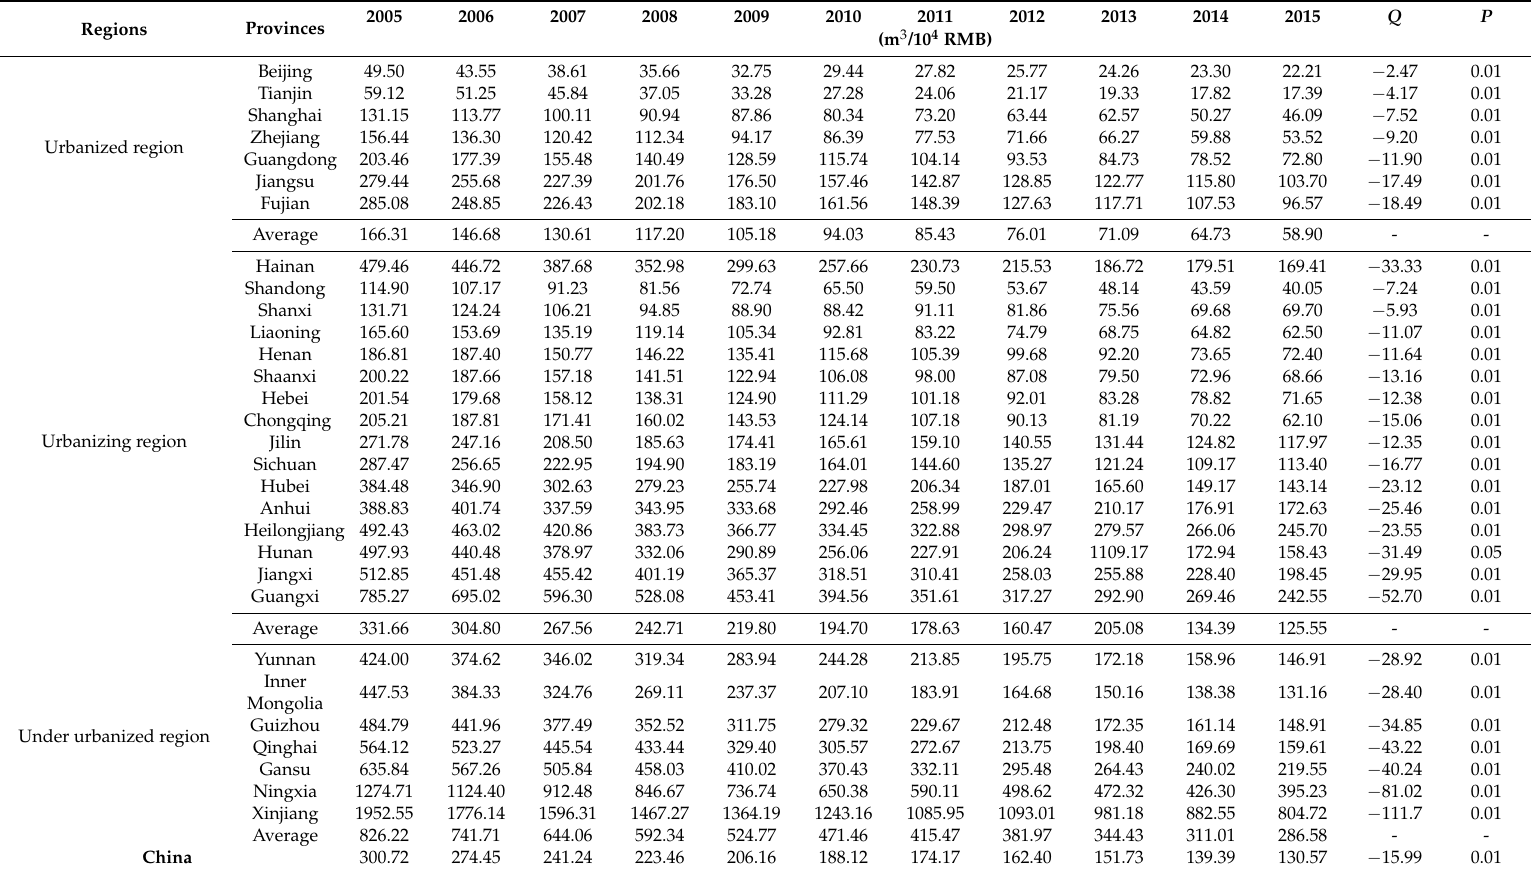
Table A1. China’s total water use intensity (WUI), Sen’s slope (Q), and significance level (P) at provincial and national levels between 2005 and